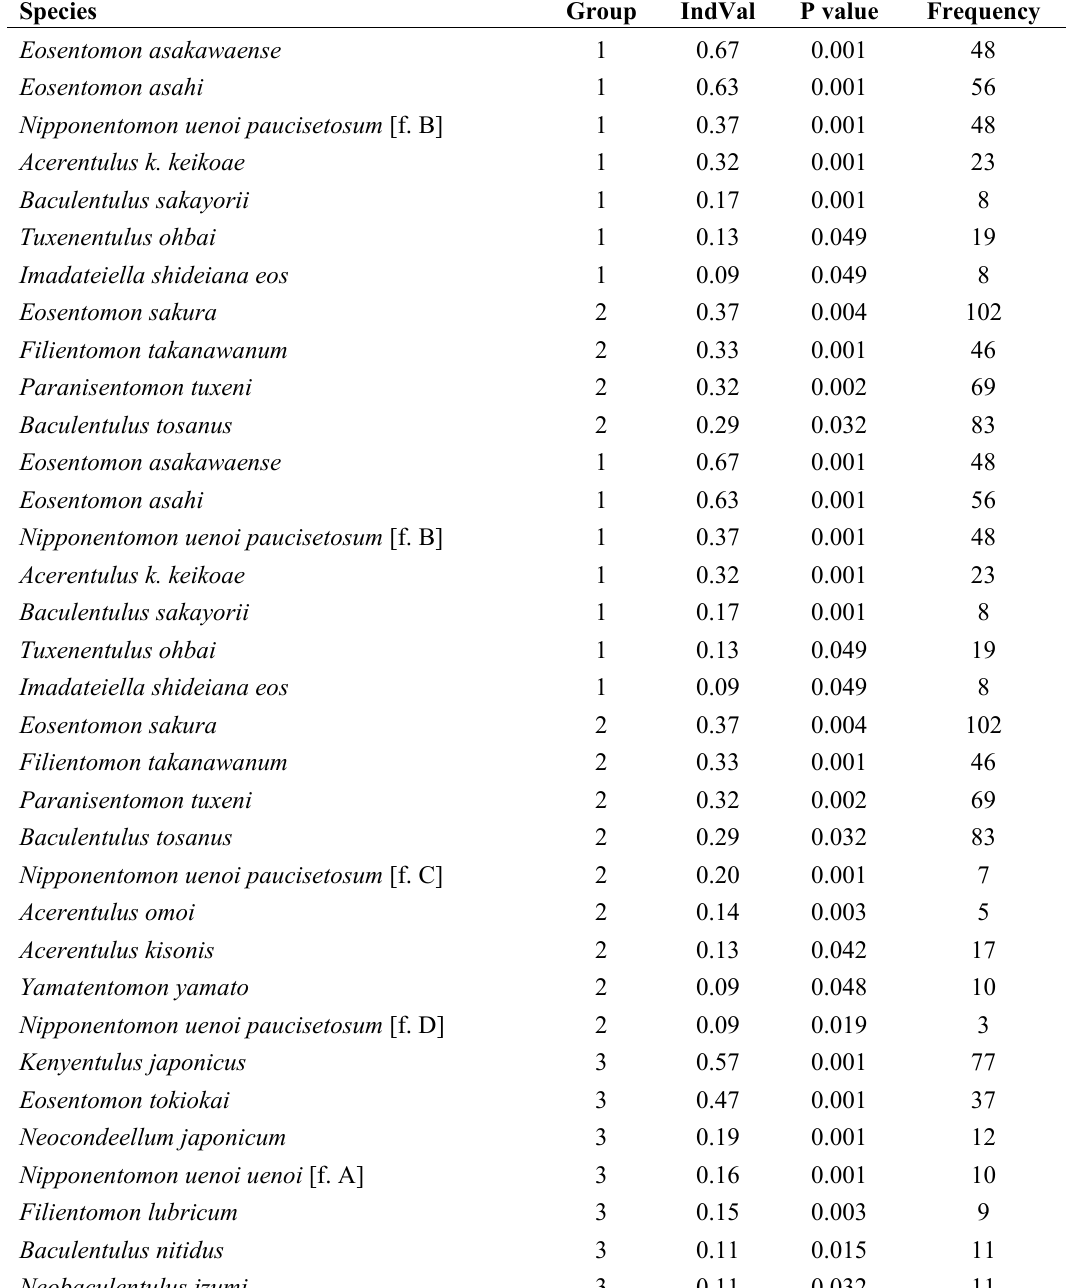
Table A2. IndVal species selected from the three assembly groups of Protura. Species Group IndVal P value Frequency Eosentomon asakawaense 1 0.67 Eosentomon